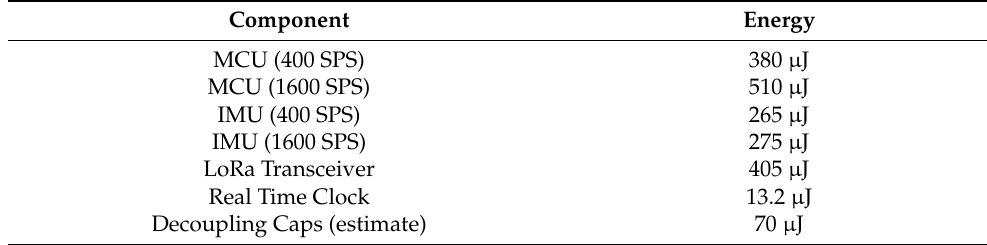
Table 1. Evaluation of required energy for the main components of the